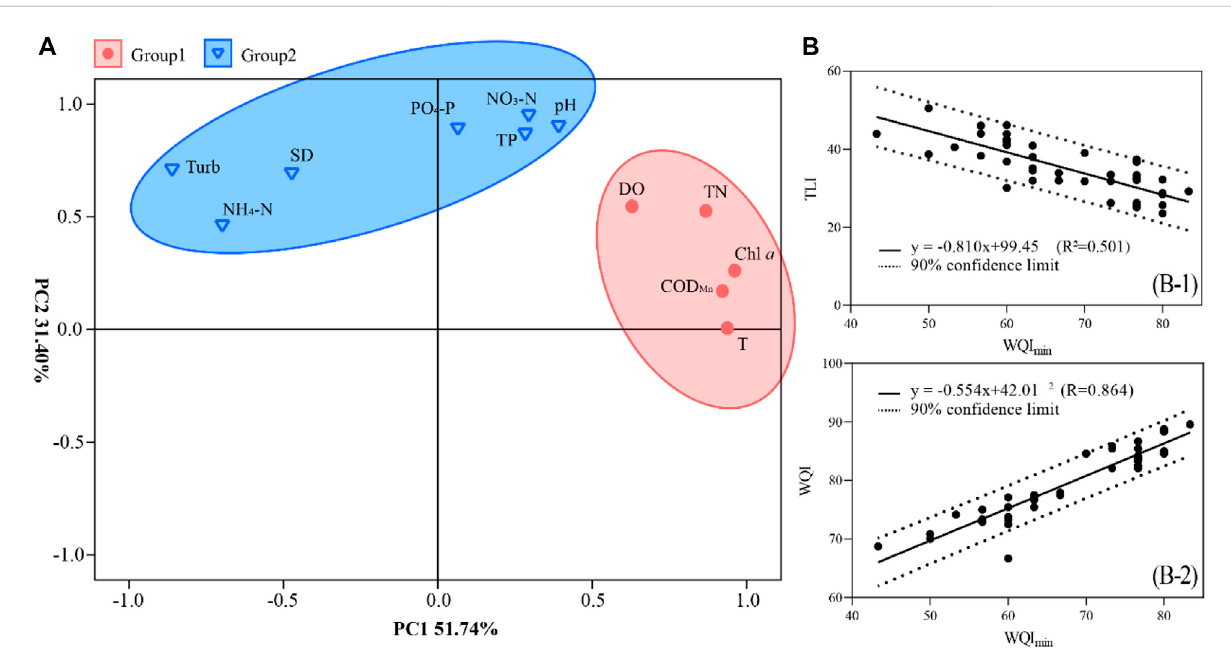
FIGURE 6 Principal component analysis and therelationship between WQI, TLI, and WQI min based on theenvironmental parameters. (A) Principal component analysis; (B) linear regression between TLI, WQI, and WQI min : (B-1) TLI with WQI min ; (B-2) WQI with WQI min.